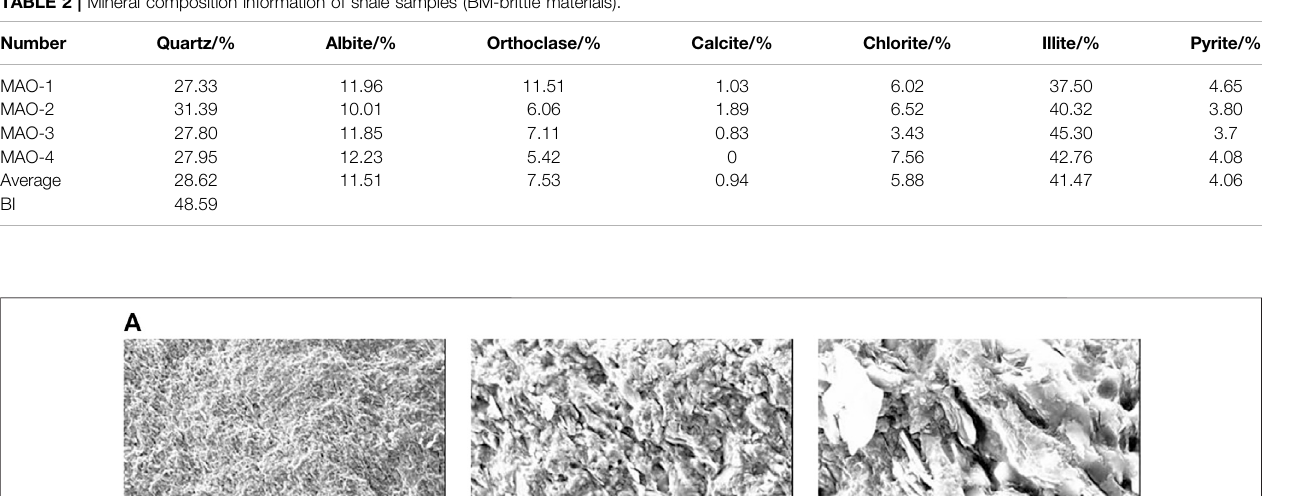
Frontiers in Earth Science |